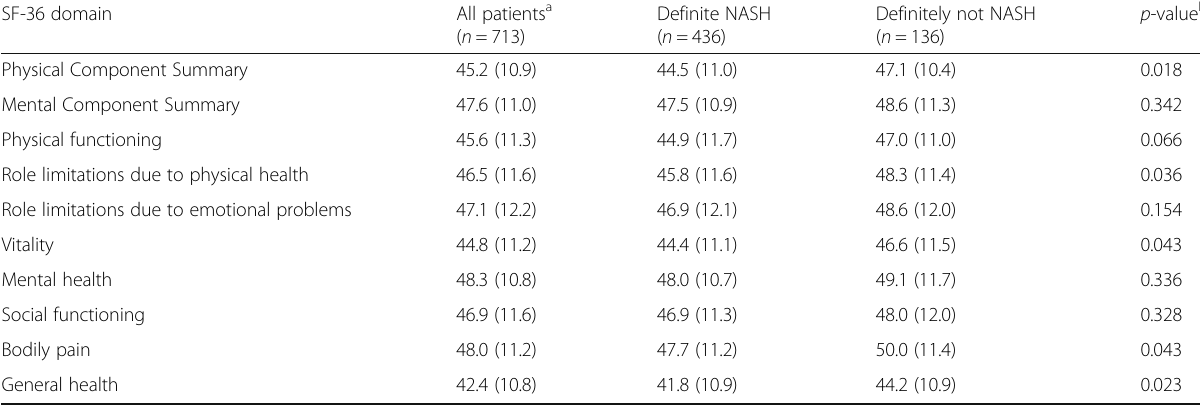
Table 3 Standardized mean (SD) SF-36 scores of patients in the NASH CRN with and without NASH (David et al., 2009) [8] SF-36 domain